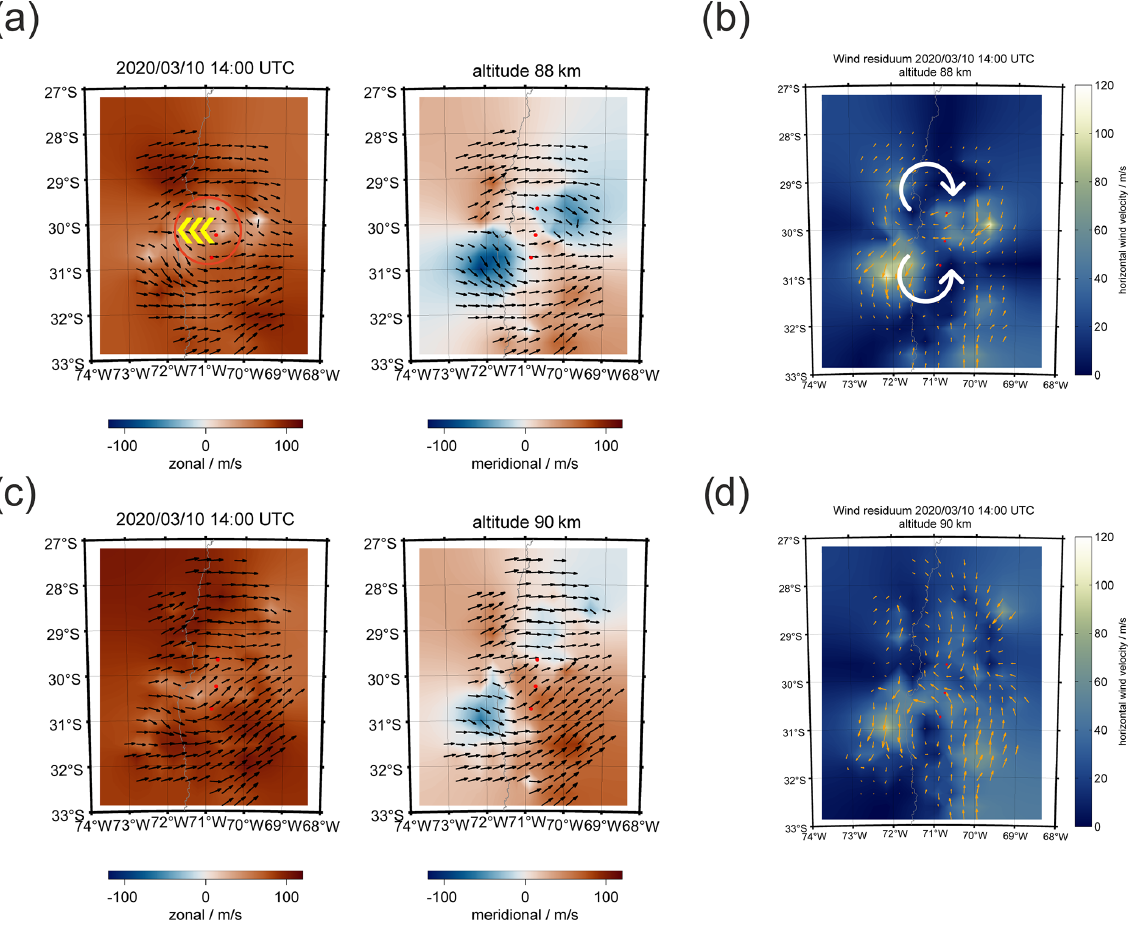
Figure 7. Body force of a breaking gravity wave above CONDOR. Panels (a) and (c) show the zonal and meridional components at 88 and 90km. Panels (b) and (d) visualize the two counter-rotating vortices after subtraction of the domain mean zonal and meridional wind. The body forcing event is indicated by a red circle, the forcing direction is given by a yellow arrow (a) , and the two vortices and their rotation direction are presented by white arrows (b) .